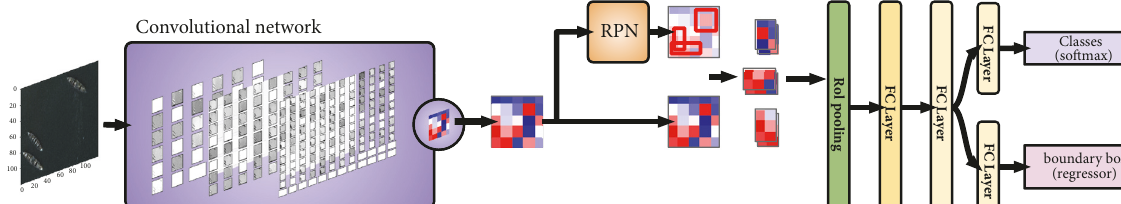
Figure 2: Faster R-CNN flow.